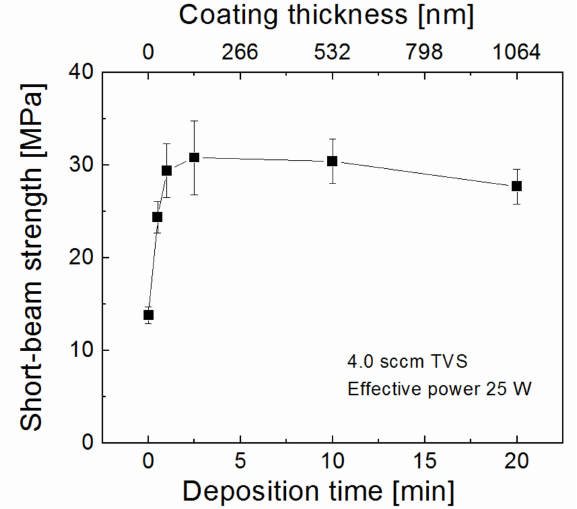
Figure 12. Short-beam strength of glass-fiber (GF) / polyester composites reinforced with GFs,